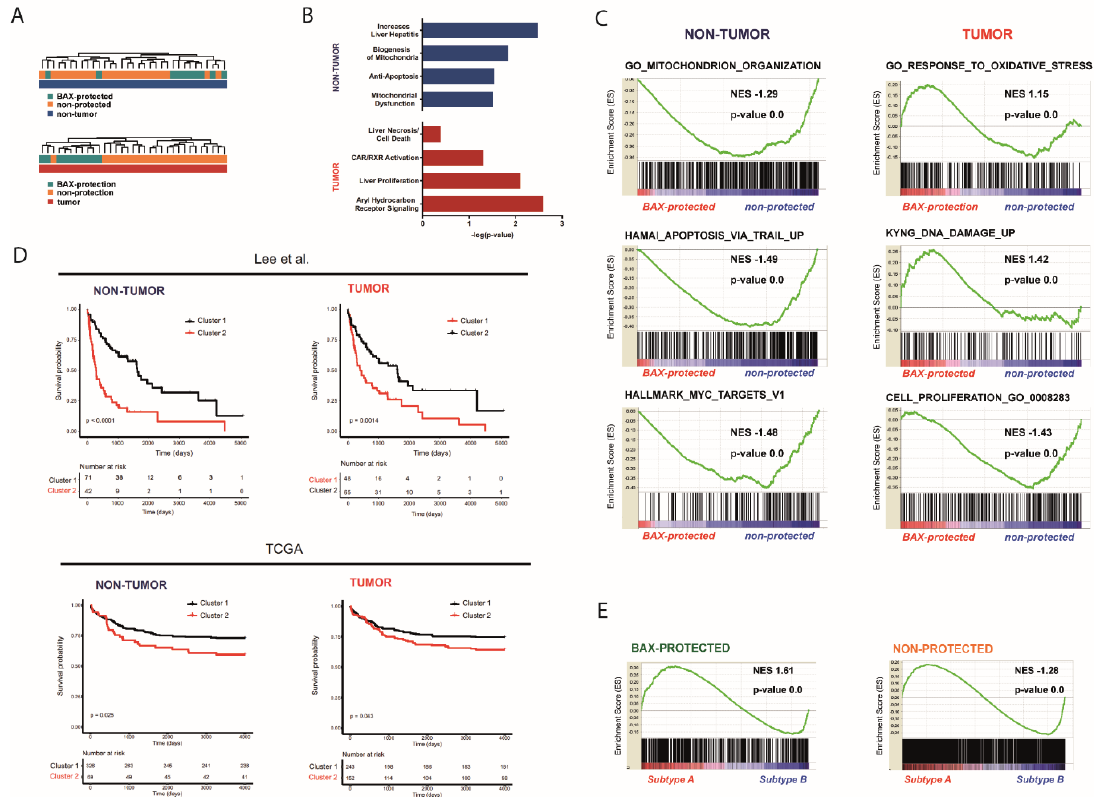
Figure 2. ( A ) Unsupervised clustering analyses based on genes di ff erently regulated between BAX-protection and non-protection subgroups in non-tumorous and tumor tissue. ( B ) Activated signaling pathways between BAX-protected and non-protected subgroups in non-tumorous and tumor tissue identified by Ingenuity pathway analyses. ( C ) Gene set enrichment analysis (GSEA) for non-tumorous and tumor tissue. Normalized enrichment score (NES) reflects degree of overrepresentation for each group at the peak of the entire set. Statistical significance calculated by nominal p -value of the ES by an empirical phenotype-based permutation test. ( D ) Kaplan–Meyer analyses based on the specific transcriptome profiles in non-tumorous and tumor tissue using public available data from authentic human HCC of 139 patients from Lee et al. and of 395 patients from the TCGA database. ( E ) Gene set enrichment analysis (GSEA) for BAX-protected and non-protected tumor associated gene expression signatures during malignant transformation on prognostic HCC subgroups (panels A and B). Normalized enrichment score (NES) reflects degree of overrepresentation for each group at the peak of the entire set. Statistical significance calculated by nominal p -value of the ES by an empirical phenotype-based permutation test.